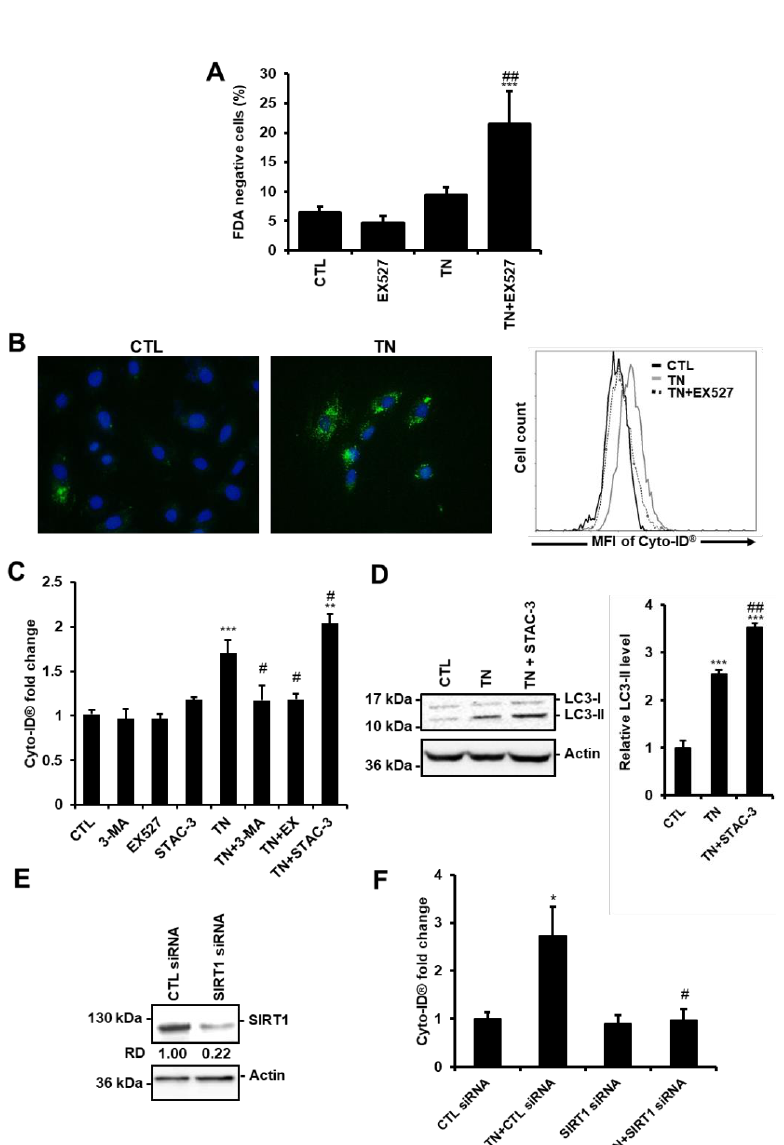
Figure 2. SIRT1 protects cardiac cells from ER stress by promoting autophagy. ( A ) H9c2 cells were left untreated or treated with 10 µ g / mL tunicamycin (TN) for 24 h ± 50 µ M EX527 (SIRT1 inhibitor) pretreatment and cell viability was assessed by Fluorescein Diacetate (FDA) assay. Results presented in the bar graph are expressed as the percentage of dead cells (FDA negative cells) (mean ± S.E.M., n = 5). ( B , C ) Cells were left untreated or treated for 24 h with 10 µ g / mL tunicamycin (TN) ± 50 µ M EX527, 5 mM 3-Methyladenine (3-MA) or 1 µ M STAC-3 (SIRT1 activator) pretreatment and autophagy was monitored by flow cytometry after staining with Cyto-ID ® probe. ( B ) Typical staining of cells with Cyto-ID ® (green) and DAPI (blue) is shown. A representative flow cytometry overlay histogram showing the mean fluorescence intensity of Cyto-ID ® (MFI) in response to tunicamycin (TN) ± 50 µ M EX527 is also presented. ( C ) Quantification of autophagy expressed as Cyto-ID ® fluorescence fold change ± S.E.M. (n = 7). ( D ) Cells were left untreated or treated with 10 µ g / mL tunicamycin (TN) for 24 h ± 1 µ M STAC-3 pretreatment and the levels of LC3-II were analyzed by Western blot. Actin was used as the loading control. Relative expression of proteins is presented in the bar graph as mean ± S.E.M (n = 7). ( E ) H9c2 cells were transfected with control or SIRT1 siRNA, and SIRT1 expression was assessed after 24 h by Western blot (n = 3). ( F ) H9c2 cells were transfected with control or SIRT1 siRNA for 24 h then treated for 24 h with tunicamycin (TN), and Cyto-ID ® fluorescence was measured by flow cytometry. Data in the bar graph represent mean ± S.E.M. (n = 3). * P < 0.05, *** P < 0.005 versus control. # P < 0.05, ## P < 0.01 versus